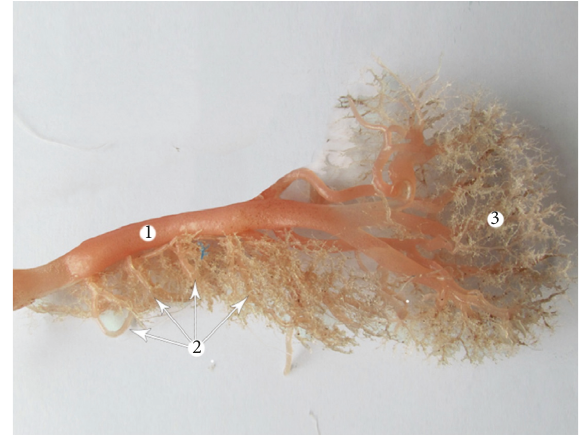
Figure 6: Type I vascular supply of the pancreas (corrosion cast).1: splenic artery; 2: short branches of the splenic artery; and 3: